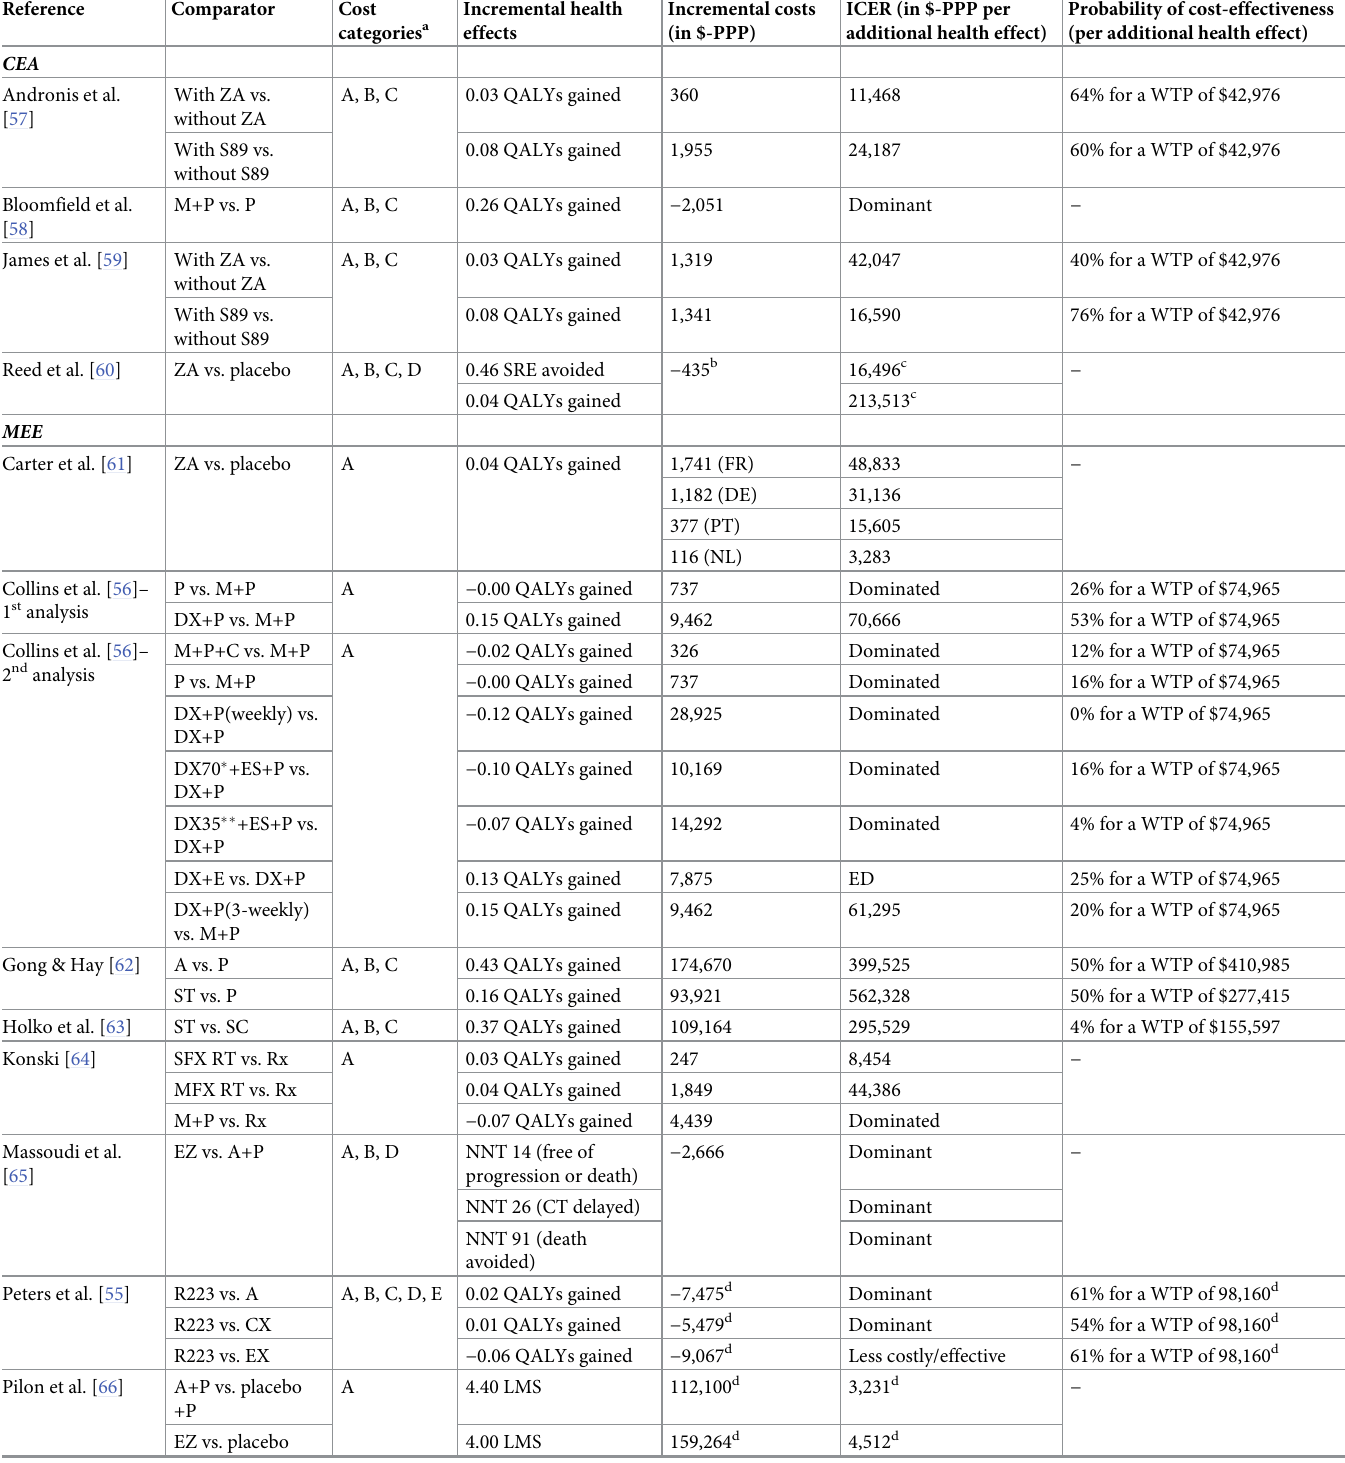
Table 3. Cost-effectiveness analyses and model economic evaluations–health effects, costs, cost-effectiveness ratios and probabilities of cost-effectiveness.